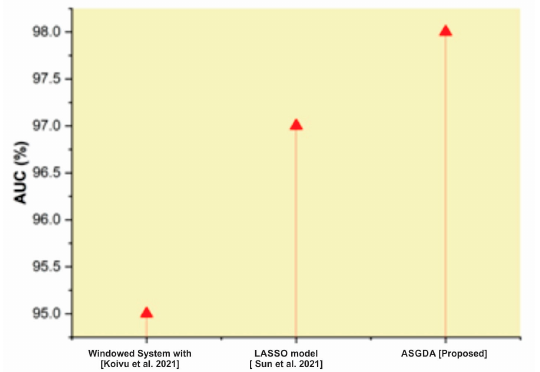
Figure 12. Comparison of AUC with the traditional and proposed method [44,45].